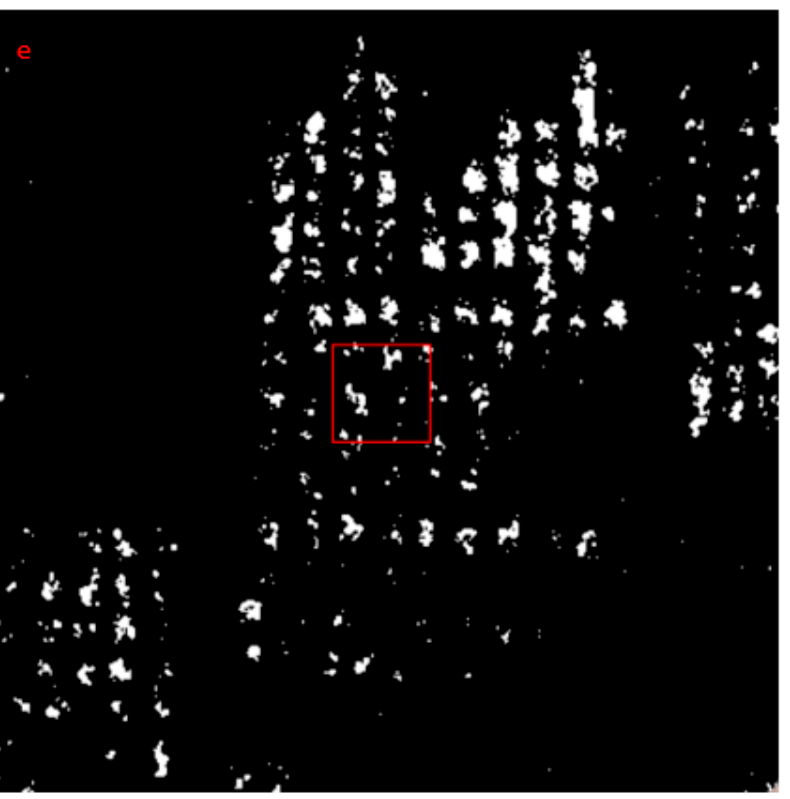
Figure 11. Non- ulva prolifera pixels after threshold segmentation. ( a ) Fragmented speckles; ( b ) Co- herent speckle noise and splicing lines between images; ( c ) Land and coast; ( d ) Vessels; ( e ) Offshore aquaculture area.